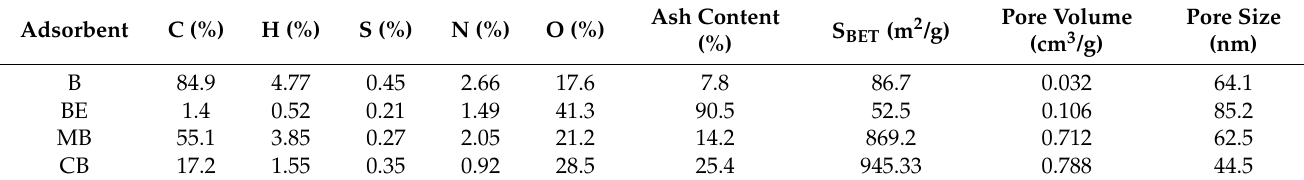
Table 1. Physiochemical properties of the four kinds of adsorbent